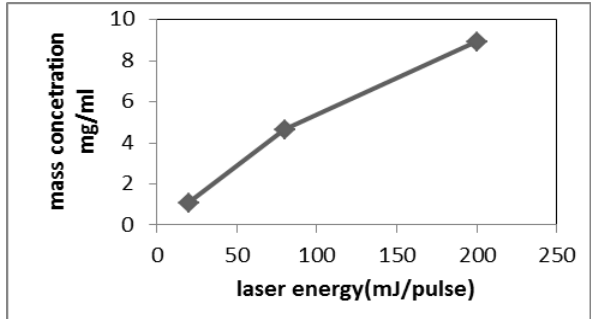
Fig.9: Carbon nanoparticles concentration as a function of the applied laser pulse energy